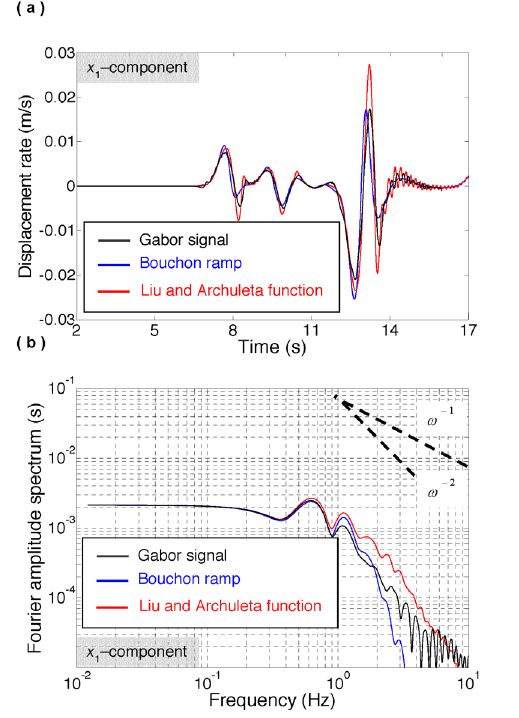
Figure 8. (a) The same as Figure 2a, but now for a free surface re- ceiver located at a distance of 40 km from the epicenter and 5 km from the fault trace. (b) Corresponding FAS.